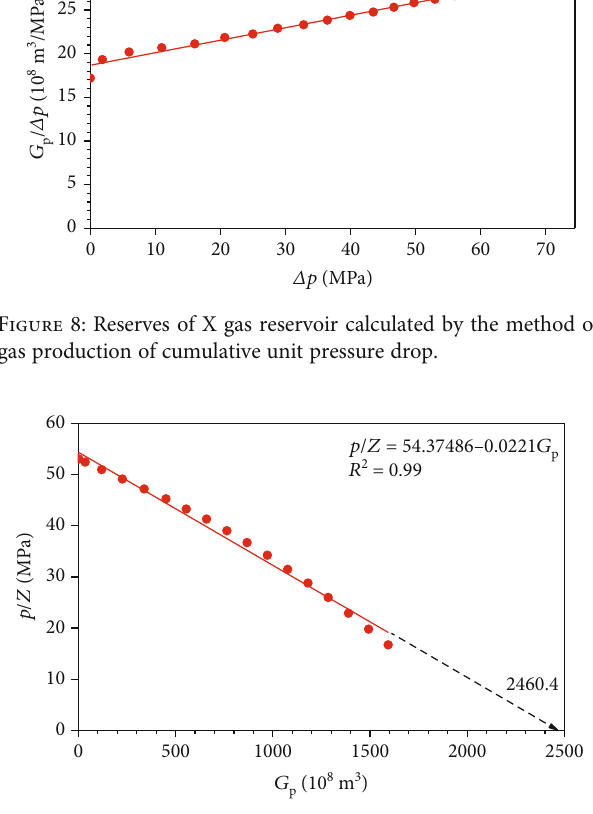
Figure 9: Reserves of X gas reservoir calculated by the p / Z method.